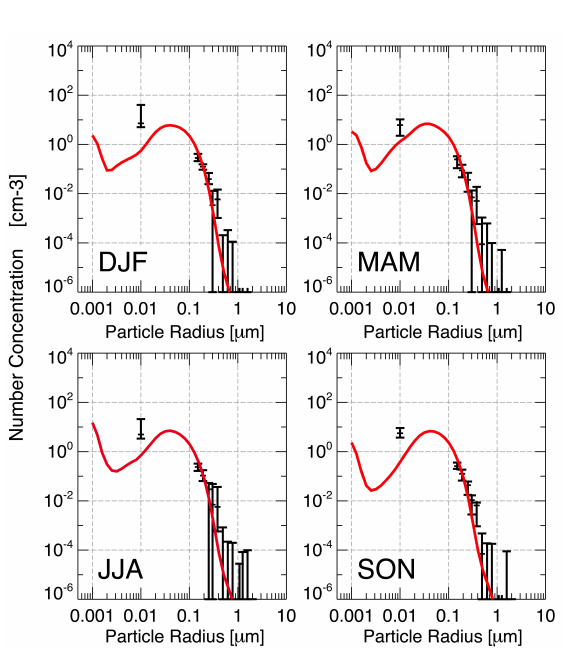
Fig. 13. Vertical profiles of the effective radius derived from OPC measurements in the stratosphere over Laramie (WY; Deshler et al., 2003a) compared to model results. The OPC data, in black, were rebinned according the vertical resolution of the model. Shown is the vertical profile of the data median. The box represents the in- terquartile range, i.e. 0.25 and 0.75 percentiels. Circles mark mean values of the measurements. The spread of the data is shown as whiskers denoting 1 . 5 × IRQ values, and outliers larger than that. Dashed lines represent R eff when the error estimates of the underly- ing surface area and volume density integrals from size distributions fitted to measurements are taken into account, details are given in Deshler et al. (2003a). The model effective radius was retrieved for the whole spectrum ( R ≥ 1 nm ; red) and for the visible range of optical instruments ( R ≥ 50 nm ; green).